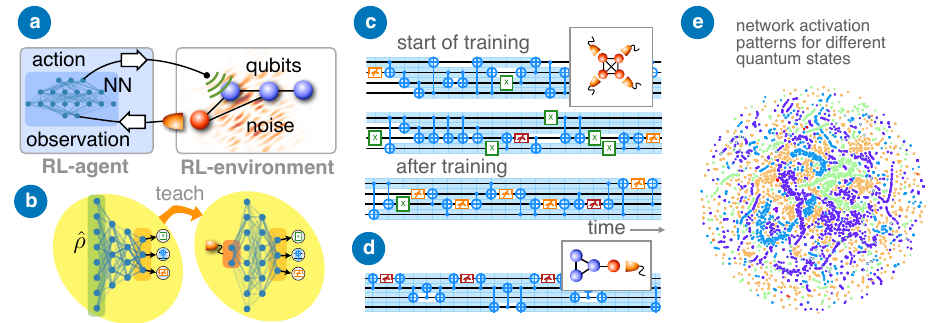
Figure 7: Discovering quantum error correction strategies from scratch [ 48 ] . (a) The setting: A neural-network-based agent controls a few qubits, applying quantum gates and measurements, with the aim of protecting the quantum information against noise. (b) RL is used for training a powerful first network that receives the quantum state ˆ ρ as input at every time step. This is then used for supervised training of a second network that only obtains the measurement results and which can be deployed in an experiment. (c,d) Quantum circuits (i.e. action sequences) for two different qubit setups. The network learns to encode the quantum information, apply periodic collective measurements (parity detection), and eventually also to correct any errors. (e) Visualization of the network activation patterns. Each point corresponds to one quantum state (reached at a particular time, in one of many trajectories). Its location is a 2D nonlinear projection (using the t-SNE method [ 49 ] ) of the high-dimensional vector of neuron activations obtained in the network for that quantum state. Different clusters (colored according to the action suggested by the network) belong to quantum states that are considered qualitatively different by the network. Using t-SNE with a higher ’perplexity’ parameter (here: 30) results in more clearly separated clusters, see [ 48 ]